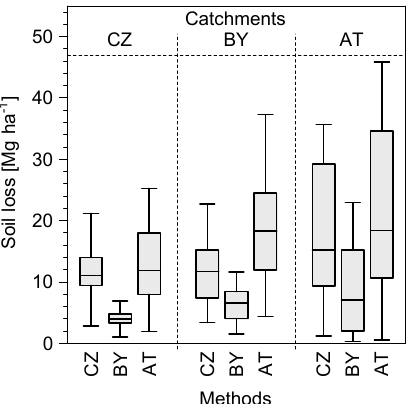
Figure 2. Boxplots of variability in soil loss based on data aggregated to parcels / fields; boxes indicate median and 25% and 75% quantiles, while whiskers give 5% and 95% quantiles.